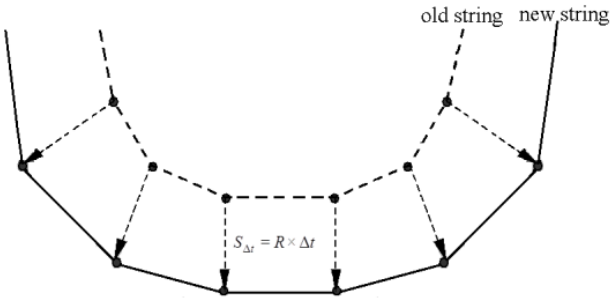
Figure 5. Schematic diagram of string algorithm.